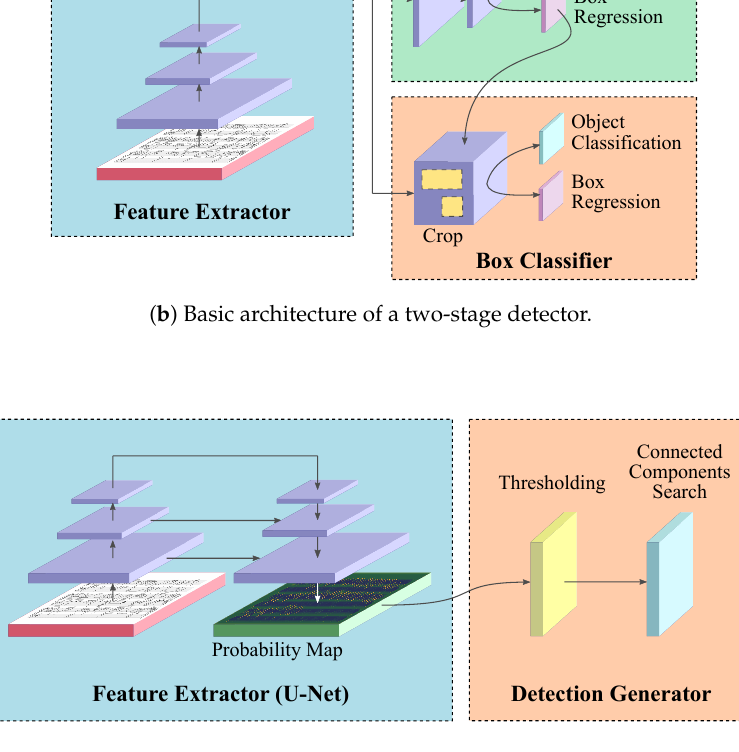
Figure 1. Basic architectures of the considered types of object